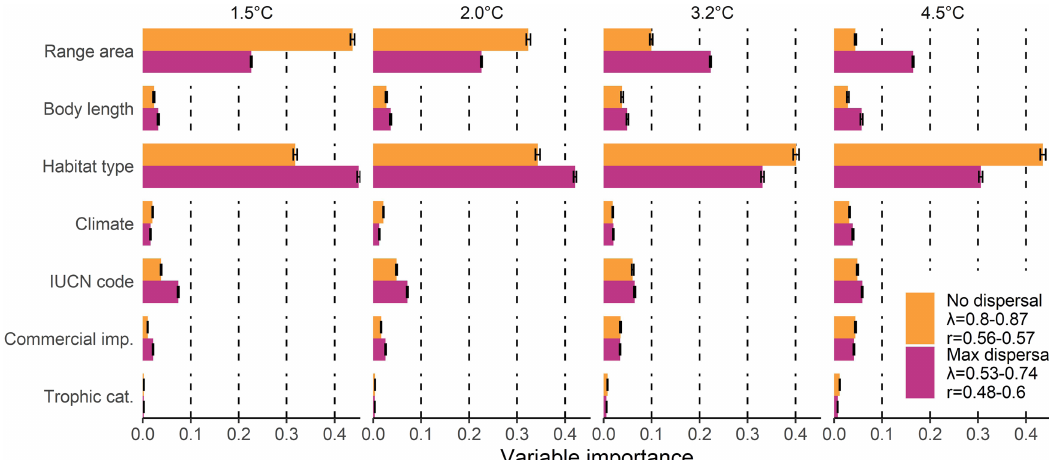
Fig. 5 Importance of various species properties in explaining the magnitude of future climate threat. Variables ’ importance is quanti fi ed based on the proportion of the geographic range exposed to climate extremes beyond current levels for two dispersal assumptions. Bars report the mean variable importance and con fi dence intervals represent the standard deviation across the 100 replicates of the stochastic phylogenetic trees. The legend includes the ranges across the different warming levels in Pagel ’ s λ and Pearson ’ s r between the predicted and observed percentage of range threatened. Coef fi cients of the underlying phylogenetic regression models are presented in Supplementary Table 5. Source data are provided as Supplementary Data